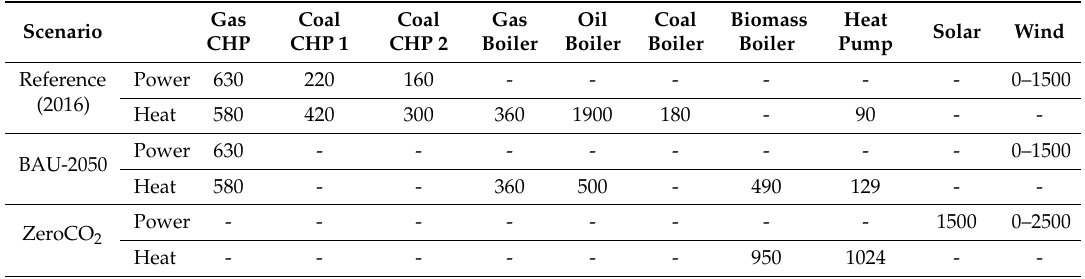
Table 2. Nominal energy plants output in Helsinki (MW) in the different scenarios for